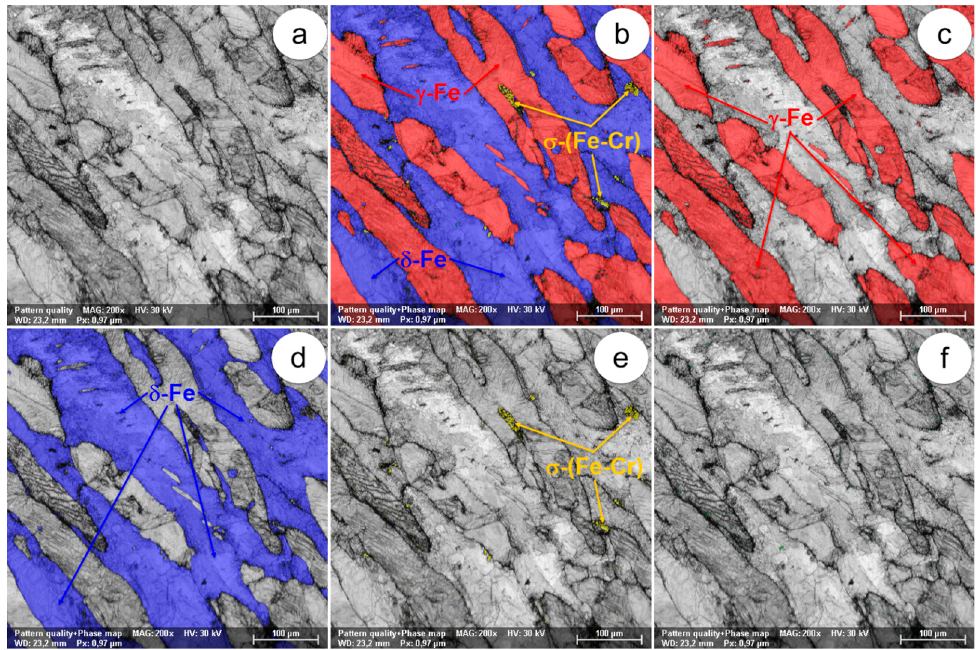
Figure 4. The SEM-EBSD composite images (×200) obtained after forging at 800 °C: ( a ) the microstructure of the analysed field; ( b ) the distribution of the existing phases in the microstructure of the analysed field; ( c ) the distribution of the γ -Fe phase; ( d ) the distribution of the δ -Fe phase; ( e ) the distribution of the σ -(Fe-Cr) phase; ( f ) the distribution of the χ -(Fe-Cr-Mo) phase. Metals 2018 , 8 , x FOR PEER REVIEW